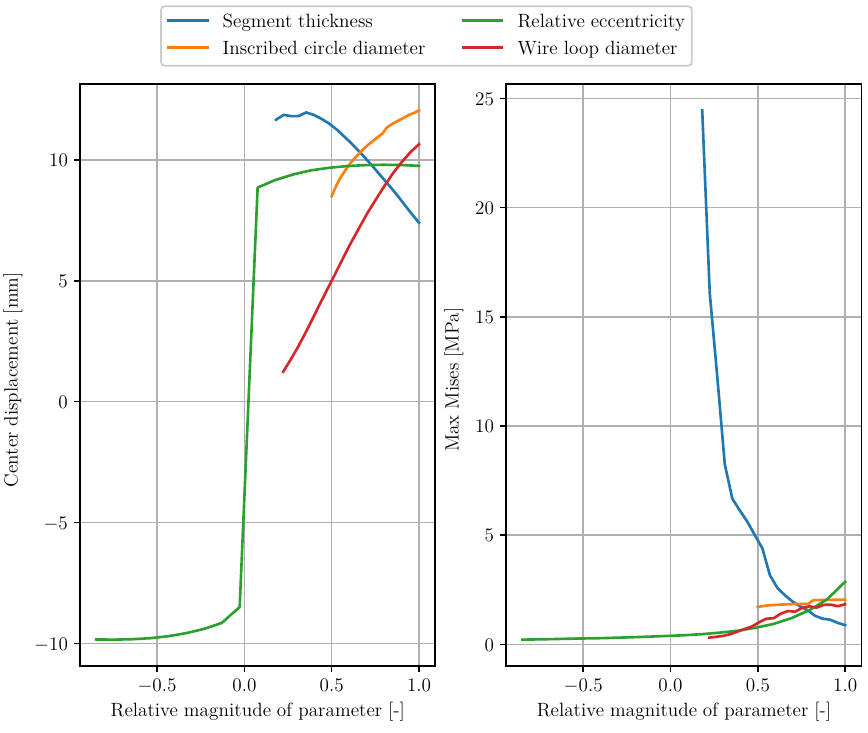
Figure 5. Max Mises vs. relative magnitude of all parameters in case of a thick ice layer on the matrix